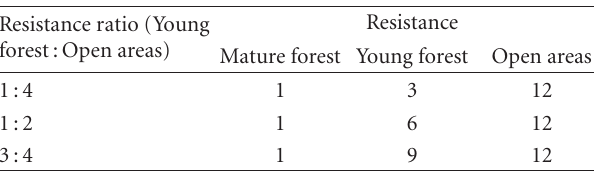
Table 1: Example of resistance values in young forest when the landscape layer is open/young/mature and the resistance value in the open is set to 12.